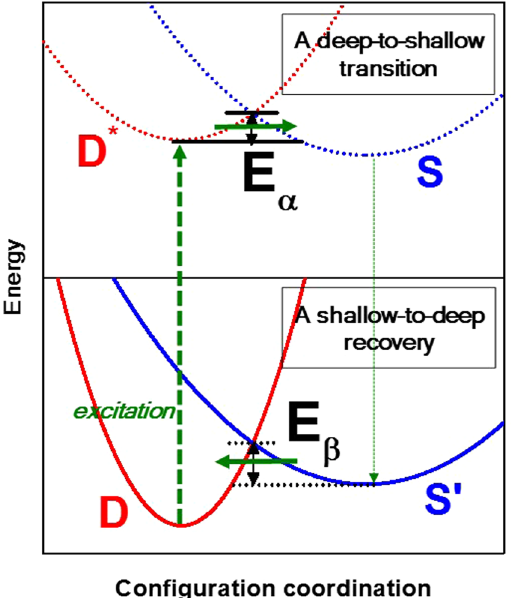
Figure 6. Schematic energy diagram for the hole-induced transition (top) and recovery (bottom) between deep and shallow states in bistable centers, explained in terms of configuration coordinates. D (D * ) and S (S ’ ), respectively, indicate the deep states without (with) the excitation of electron carriers [ i . e . V O0 , V N + , and 2O 2